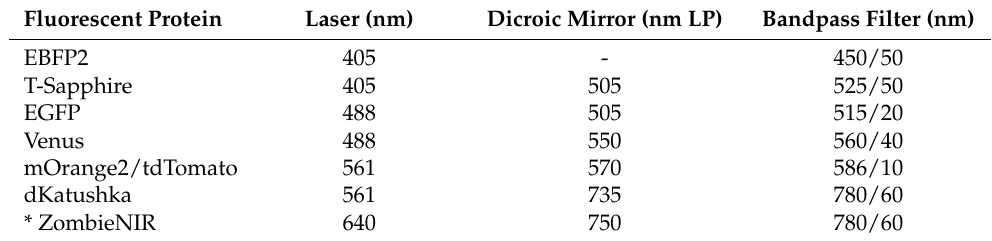
Table 2. Configuration of the BD LSR